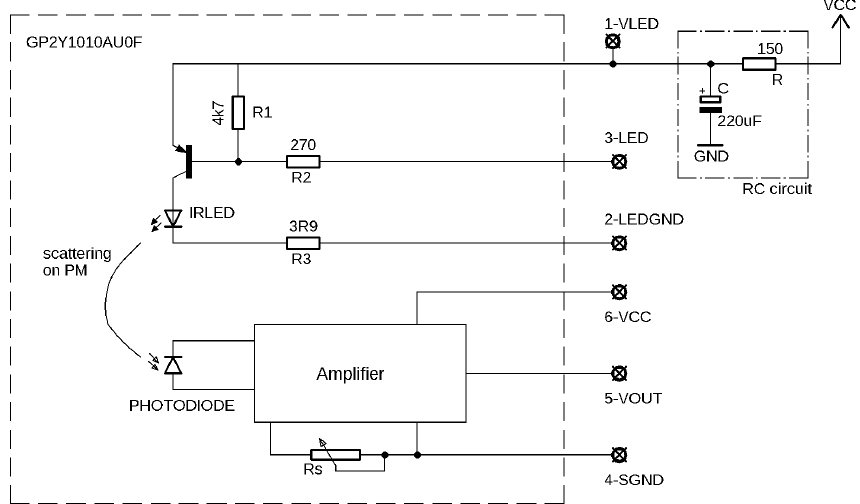
Figure 1. Sensor schematics with manufacturer’s recommended RC circuit. Redrawn with permission from the Data sheet [15]. The values of the elements R1—R3 are measured on one specific sensor and are not given by the